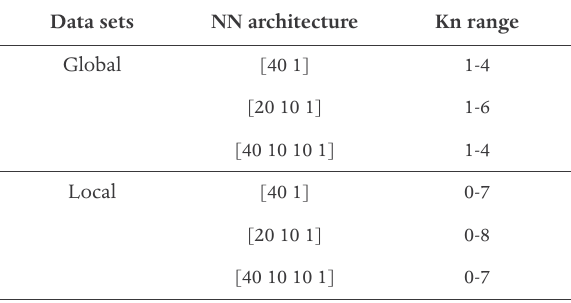
Table 2. Summary of the Kn range depending on data set and neu- ral network